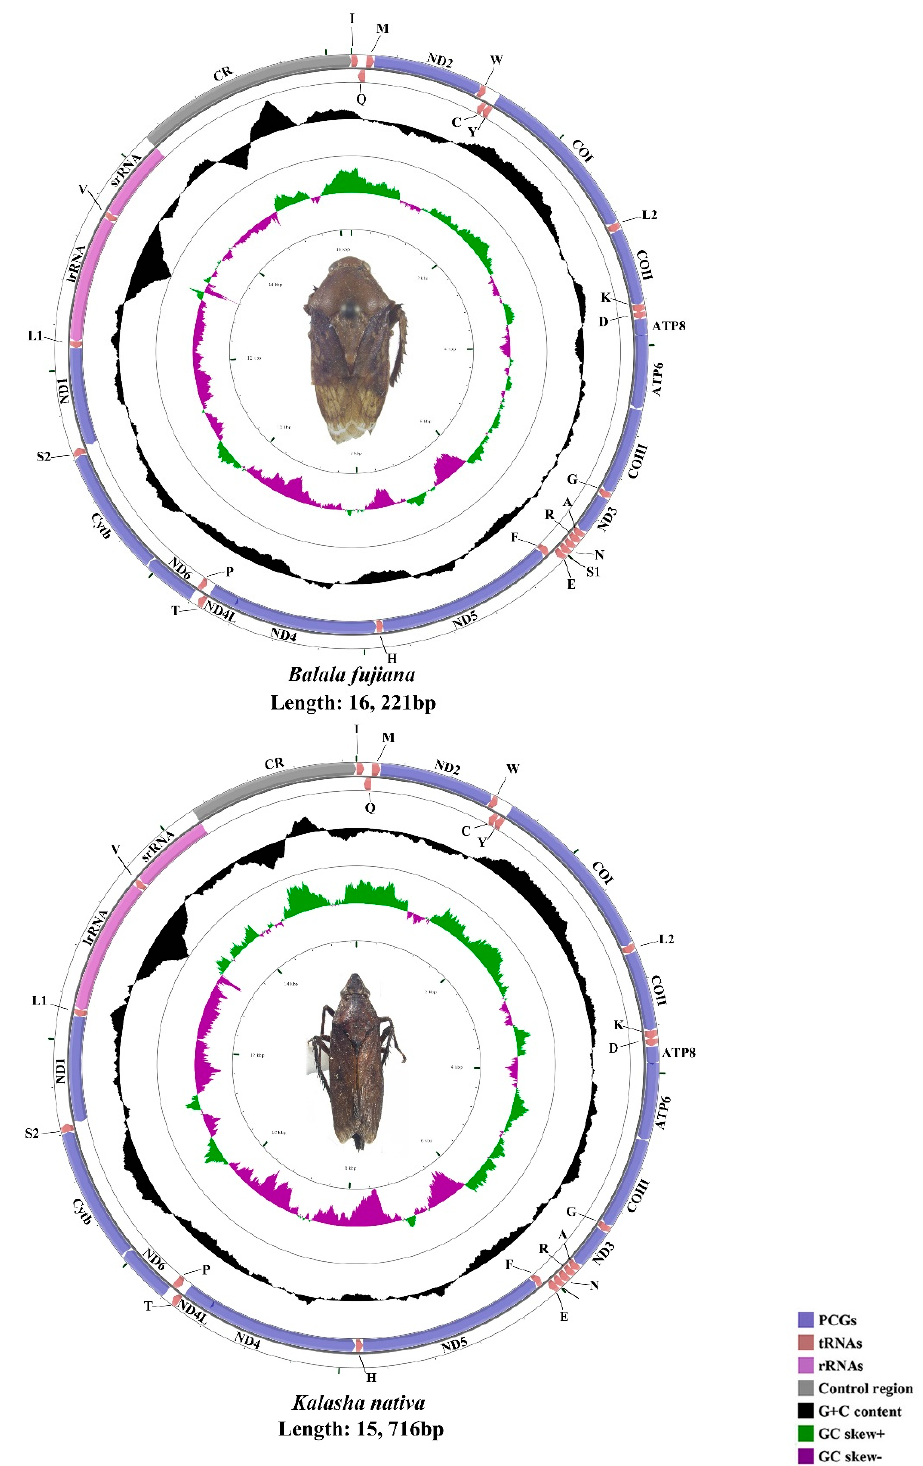
Figure 2. The circular 16.2 kb B. fujiana and 15.7 kb K. nativa mtgenomes .